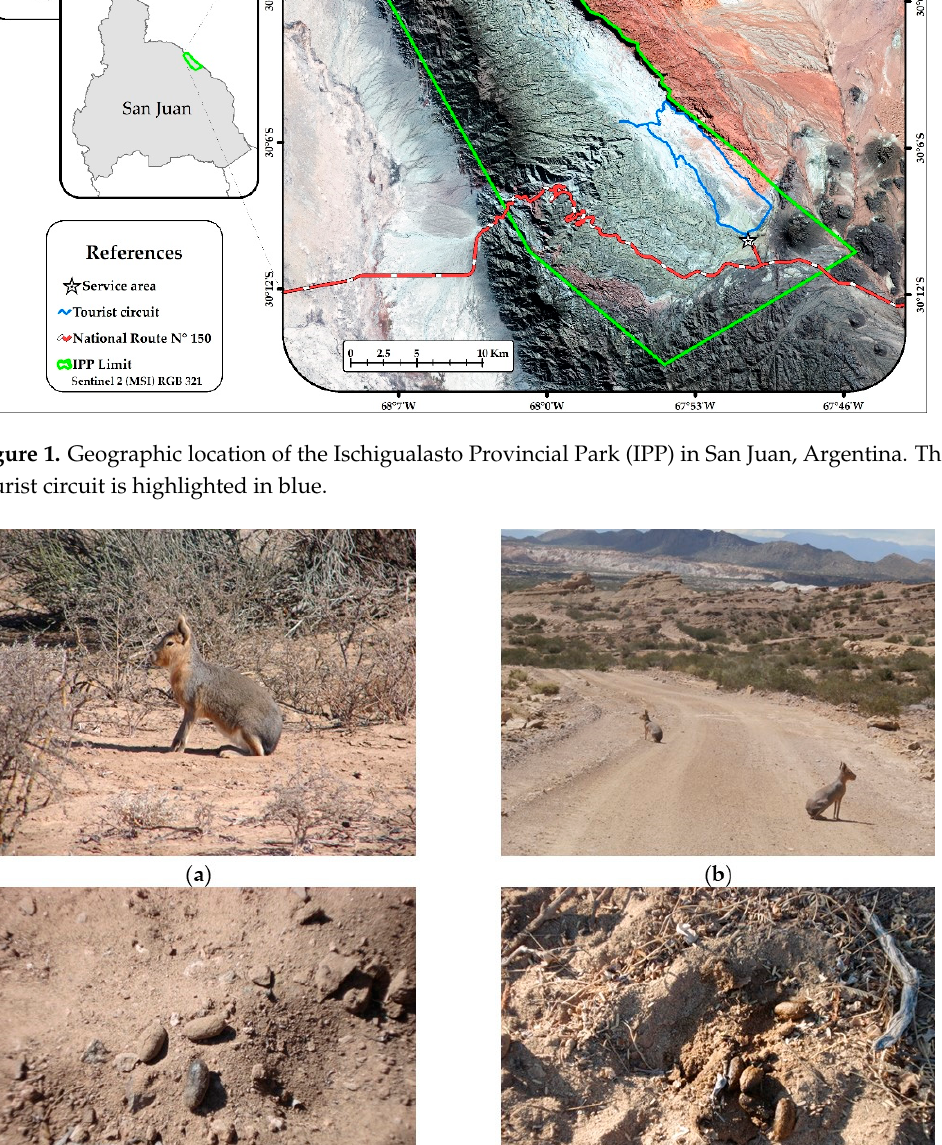
Figure 1. Geographic location of the Ischigualasto Provincial Park (IPP) in San Juan, Argentina. The tourist circuit is highlighted in blue.